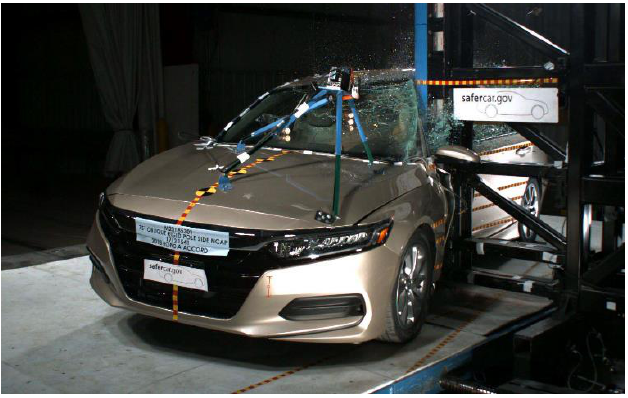
Figure 4. Dynamic maximal deformation in impact test [10]. Available online: https://www.nhtsa.gov/vehicle/2018/HONDA/ACCORD/4%252520DR/FWD (accessed on 25 October 2021).